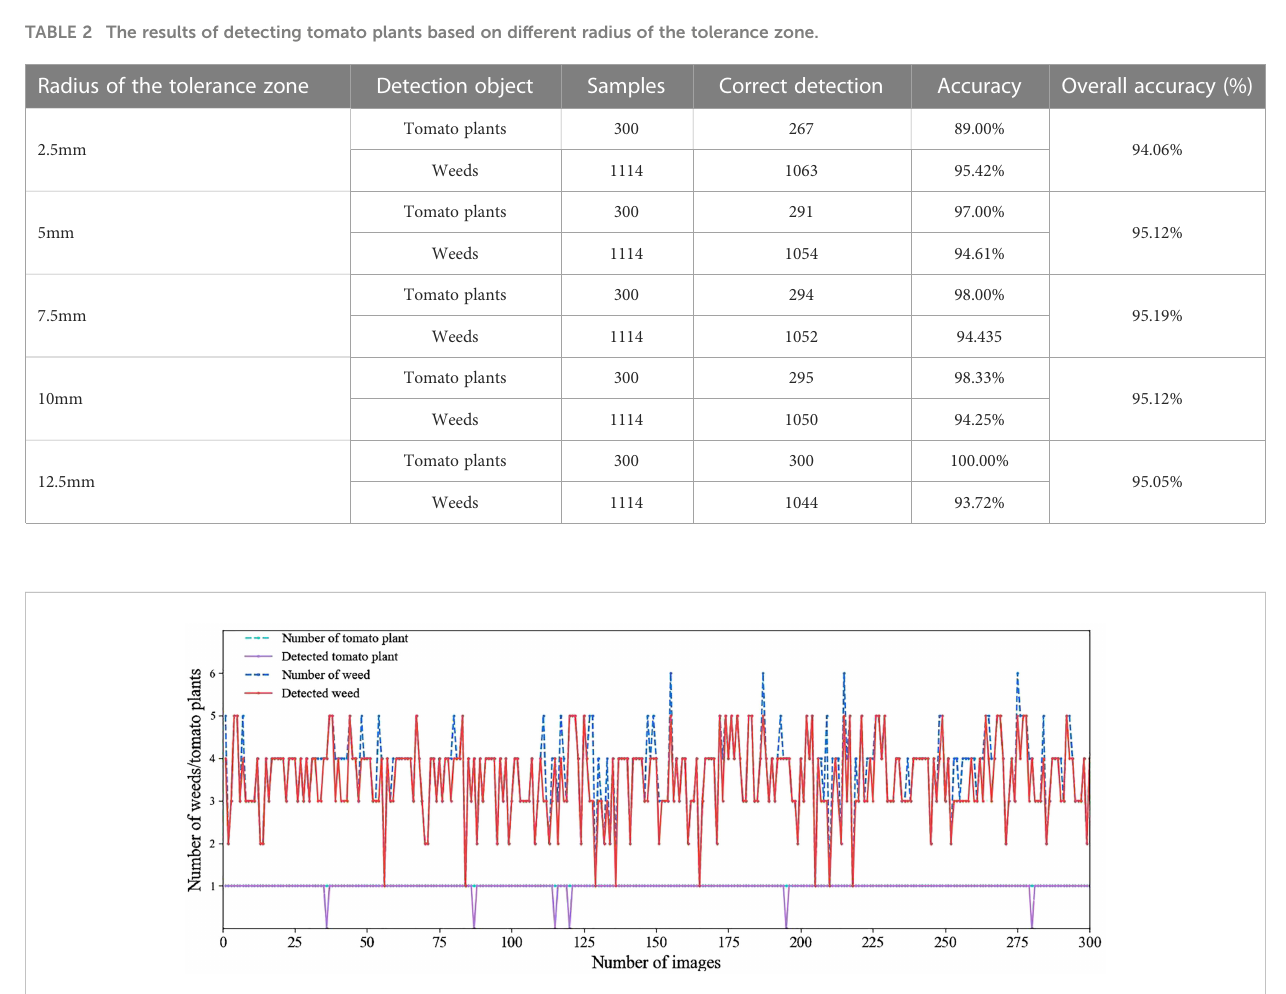
FIGURE 8 The weed and crop analysis per image: the number of weed/crop present in each image and the weed/crop in each image actually detected by the